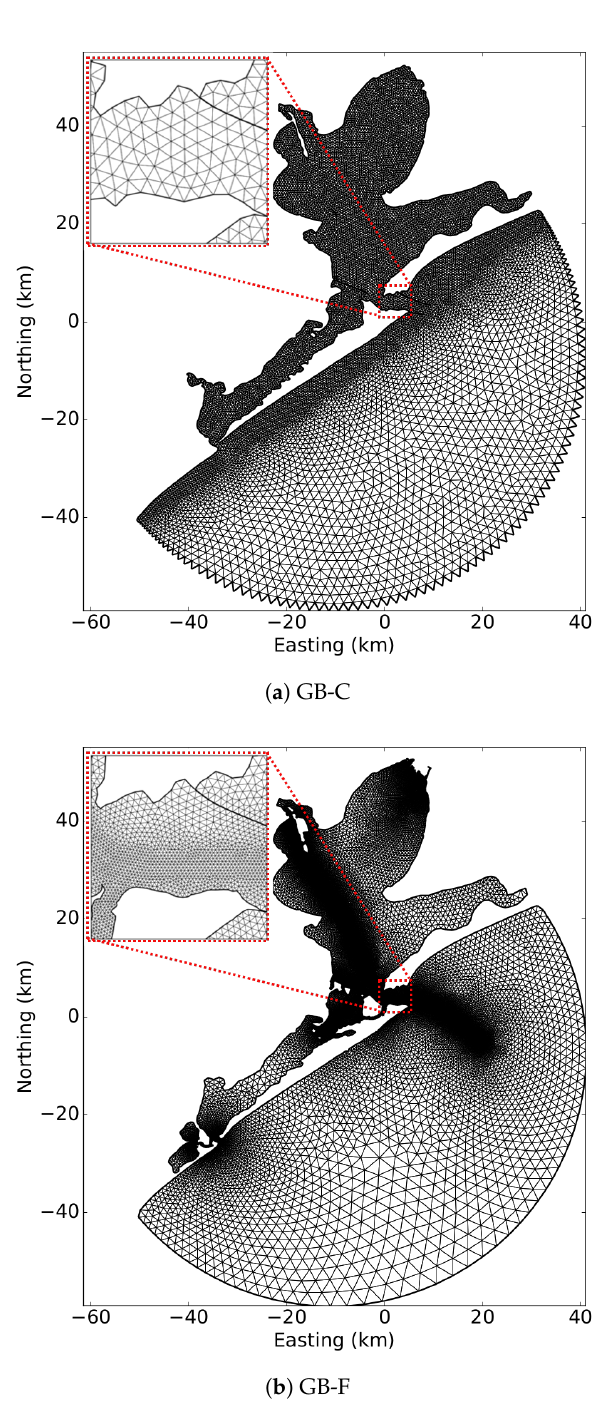
Figure 1. The unstructured model grids of the GB-C and GB-F models and the corresponding magnified views at the